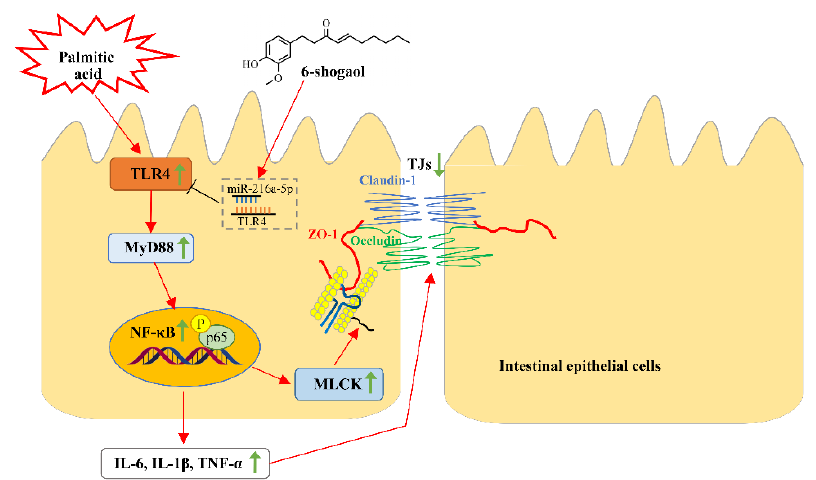
Figure 9. A schematic diagram illustrating the possible mechanisms underlying the protective effects of 6-shogaol against PA-induced intestinal barrier dysfunction. Green arrows ↑ and ↓ indicate that the proteins or cytokines are upregulated and downregulated, respectively.